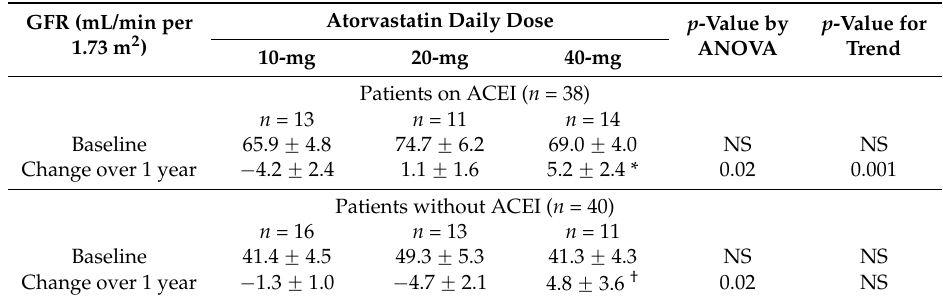
Table 2. Glomerular filtration rate (GFR) by atorvastatin dose according to the use of angiotensin-converting enzyme inhibitors (ACEI).